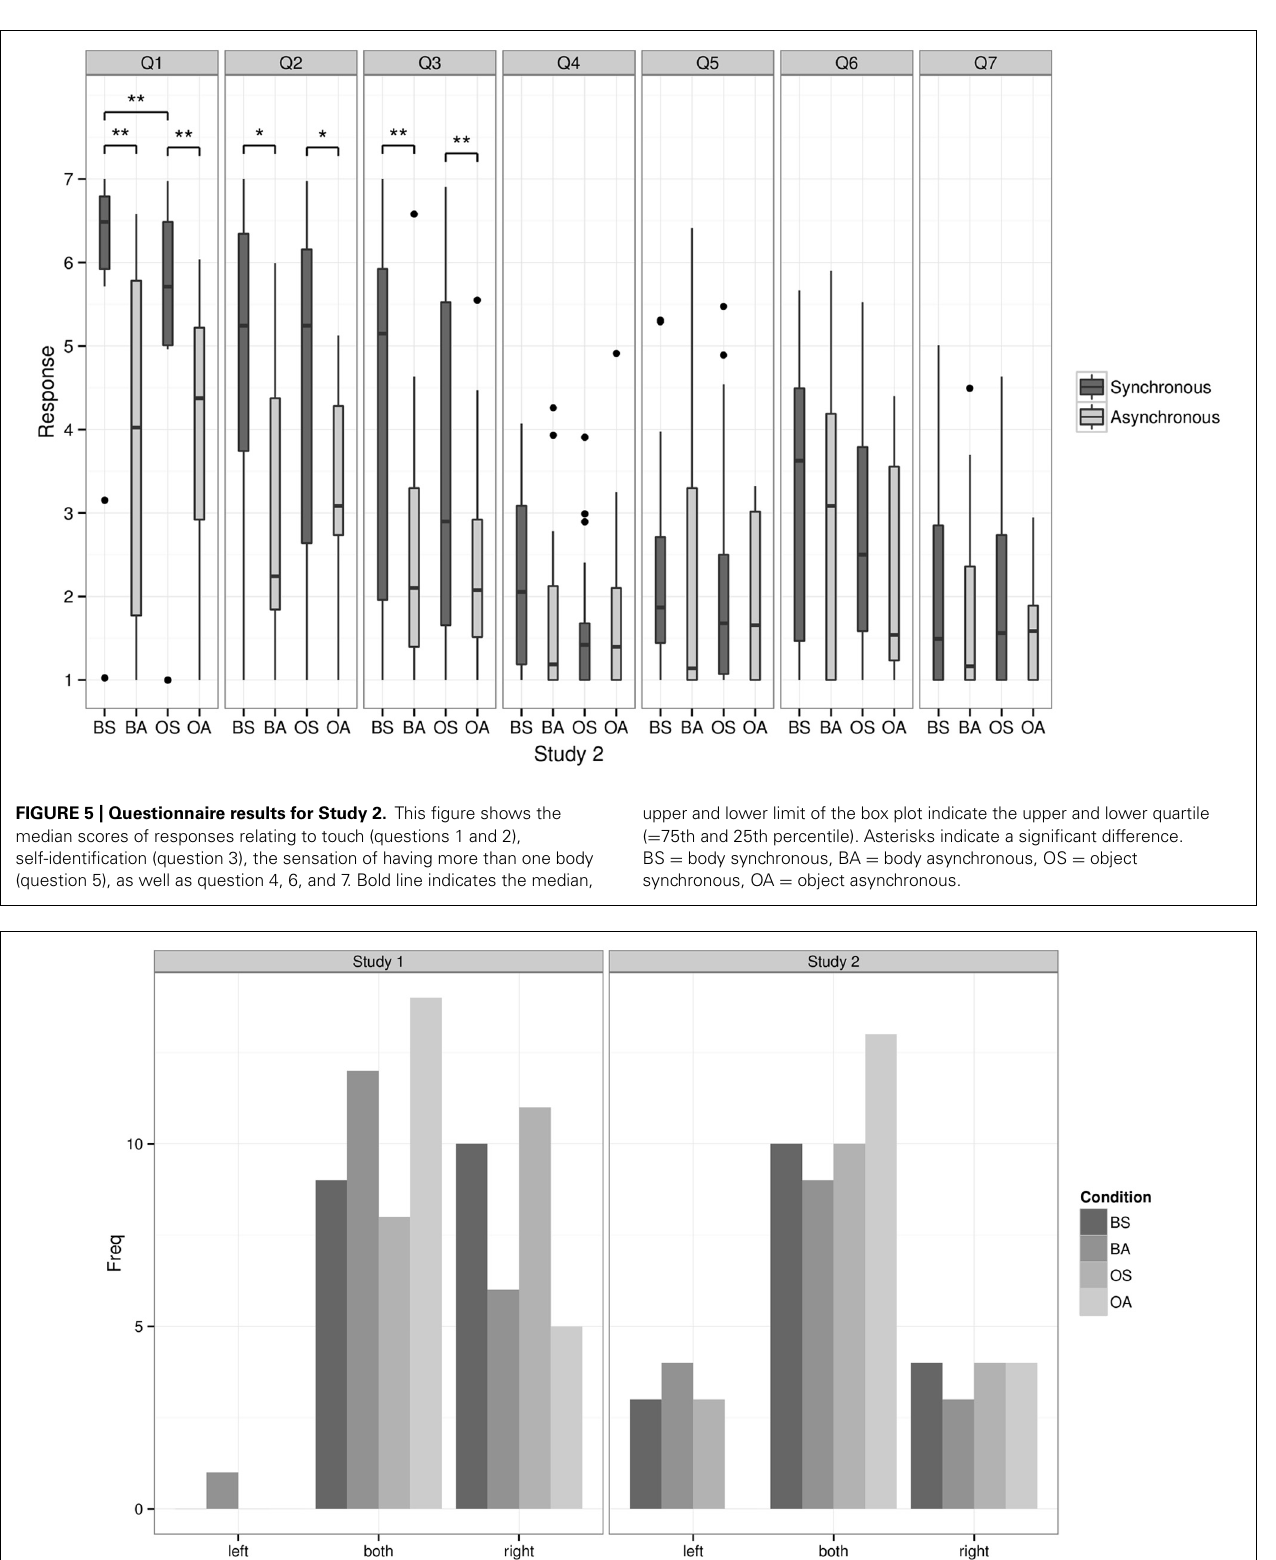
FIGURE 5 | Questionnaire results for Study 2. This figure shows the median scores of responses relating to touch (questions 1 and 2), self-identification (question 3), the sensation of having more than one body (question 5), as well as question 4, 6, and 7. Bold line indicates the median,